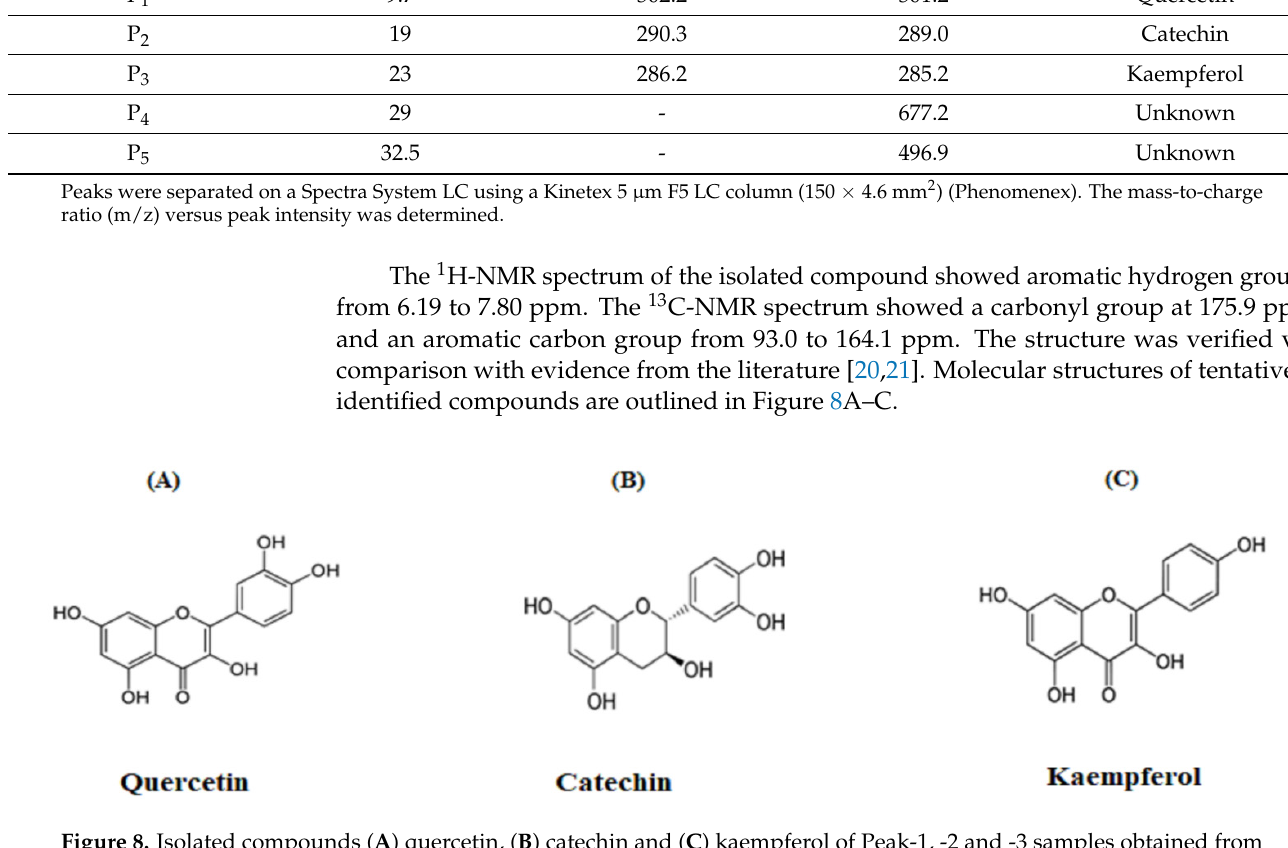
Table 1. Molecular mass and predicted identity of peak samples of A. arabica bark obtained from the preparative RP-HPLC via LC-MS analysis.